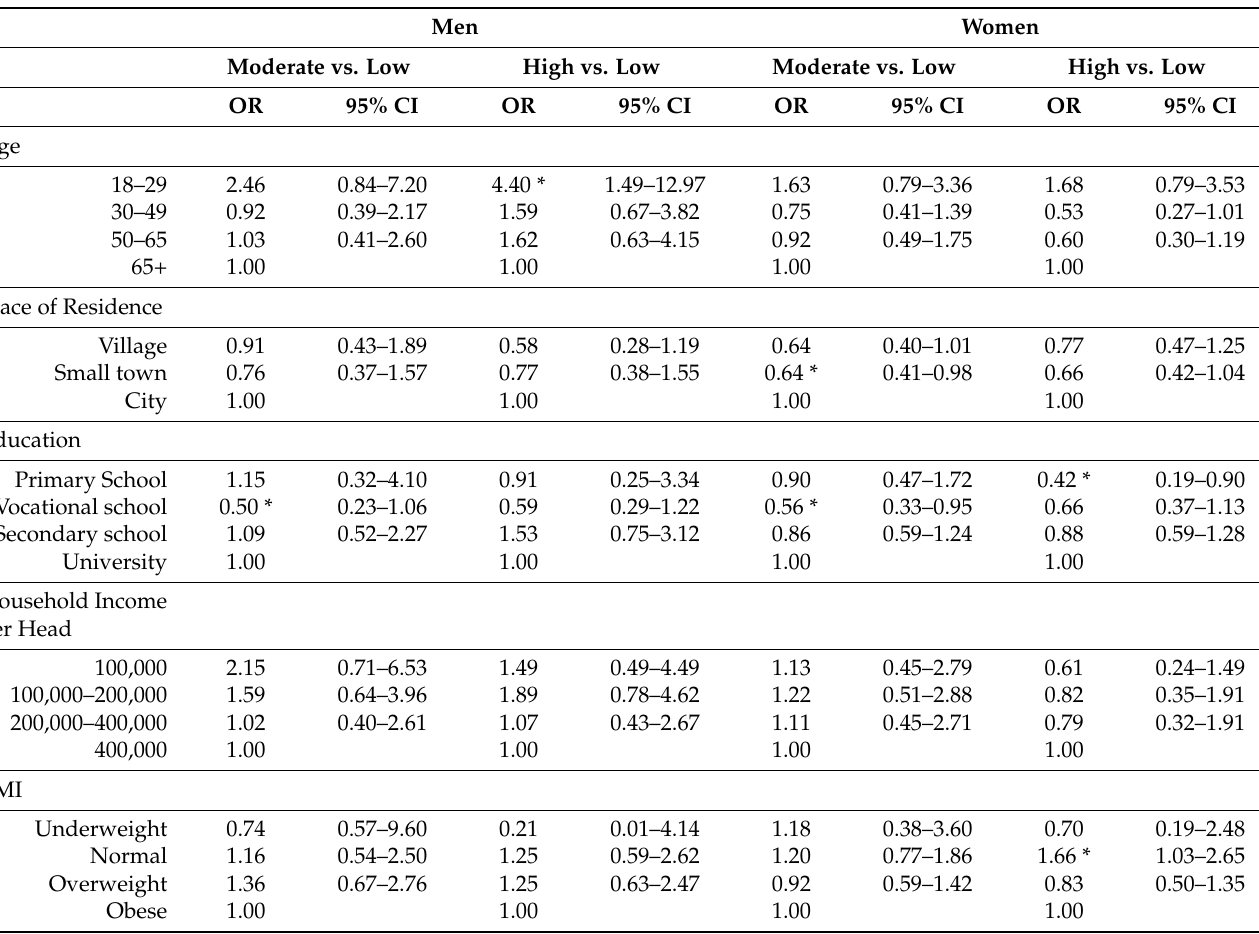
Table 3. Gender specific associations between low, moderate, and high physical